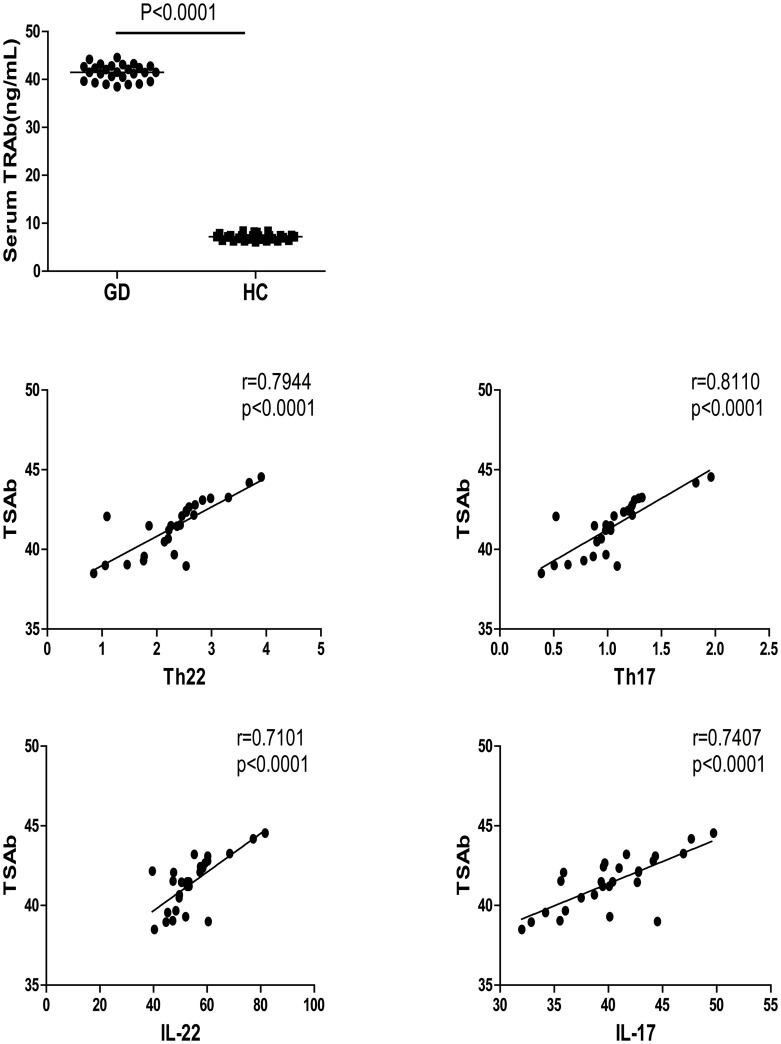
The concentrations of serum TSAb in the subjects.The concentrations of serum TSAb in individual subjects were measured by ELISA, and the potential correlations between the levels of serum TSAb and the percentages of Th22, Th17 cells, and the levels of serum IL-17 and IL-22 in the GD patients were analyzed by Spearman rank correlation test. Data are expressed as the mean values of individual patients (n = 27). There was no significant association between the percentages of Th17, Th22, or the levels of plasma IL-17 and IL-22 and the levels of serum FT3, FT4, and TSH in those patients (data not shown).